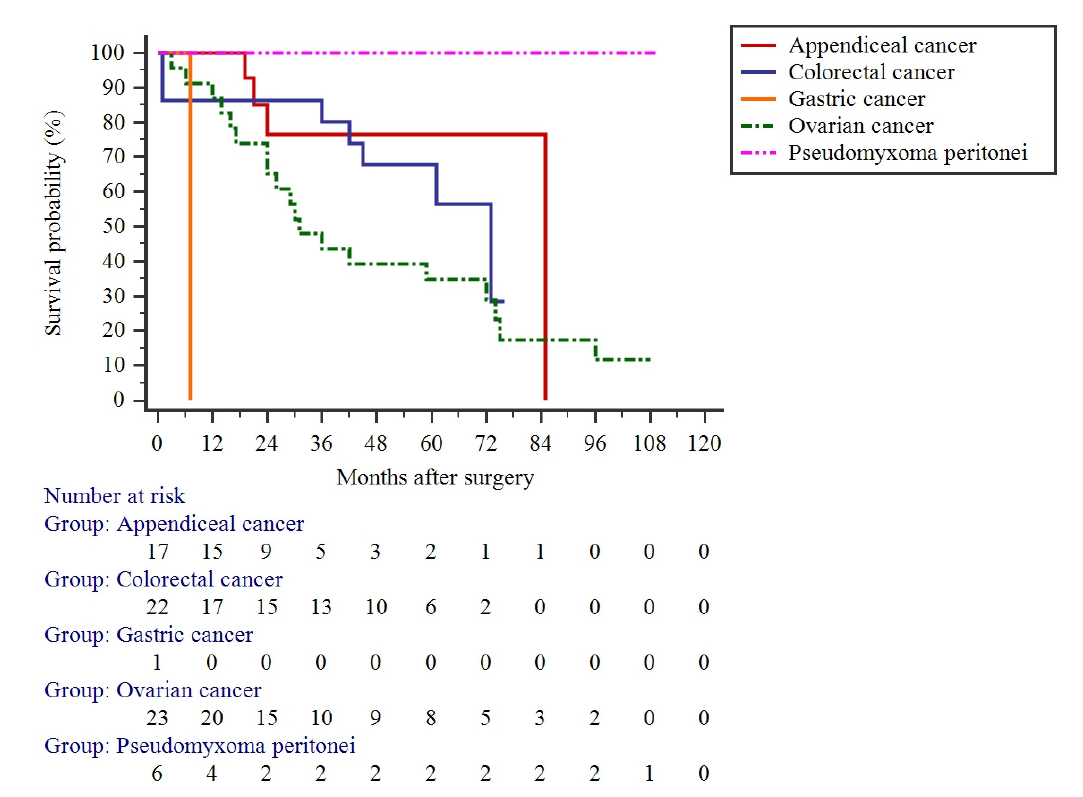
Figure 1. Overall survival of patients who underwent cytoreductive surgery and hyperthermic intraperitoneal chemotherapy for peritoneal surface malignancies.